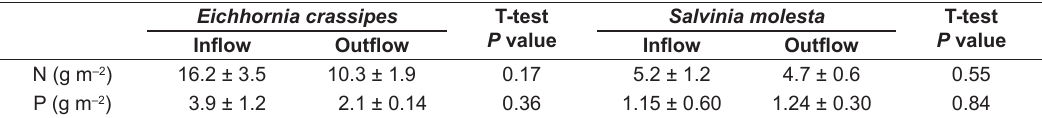
Table 4. Mean of nitrogen (N) and phosphorus (P) stocks in the biomasses of aquatic macrophytes observed in the inflow and outflow of the tanks and P values (n = 3; ± standard